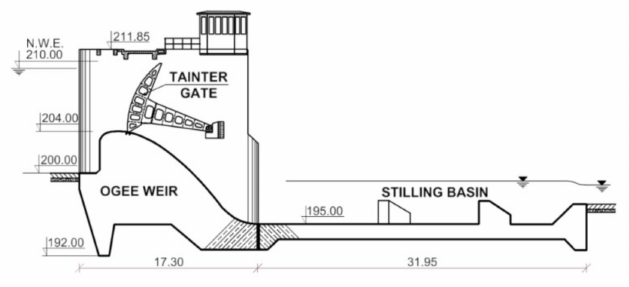
Figure 3. Ogee weir